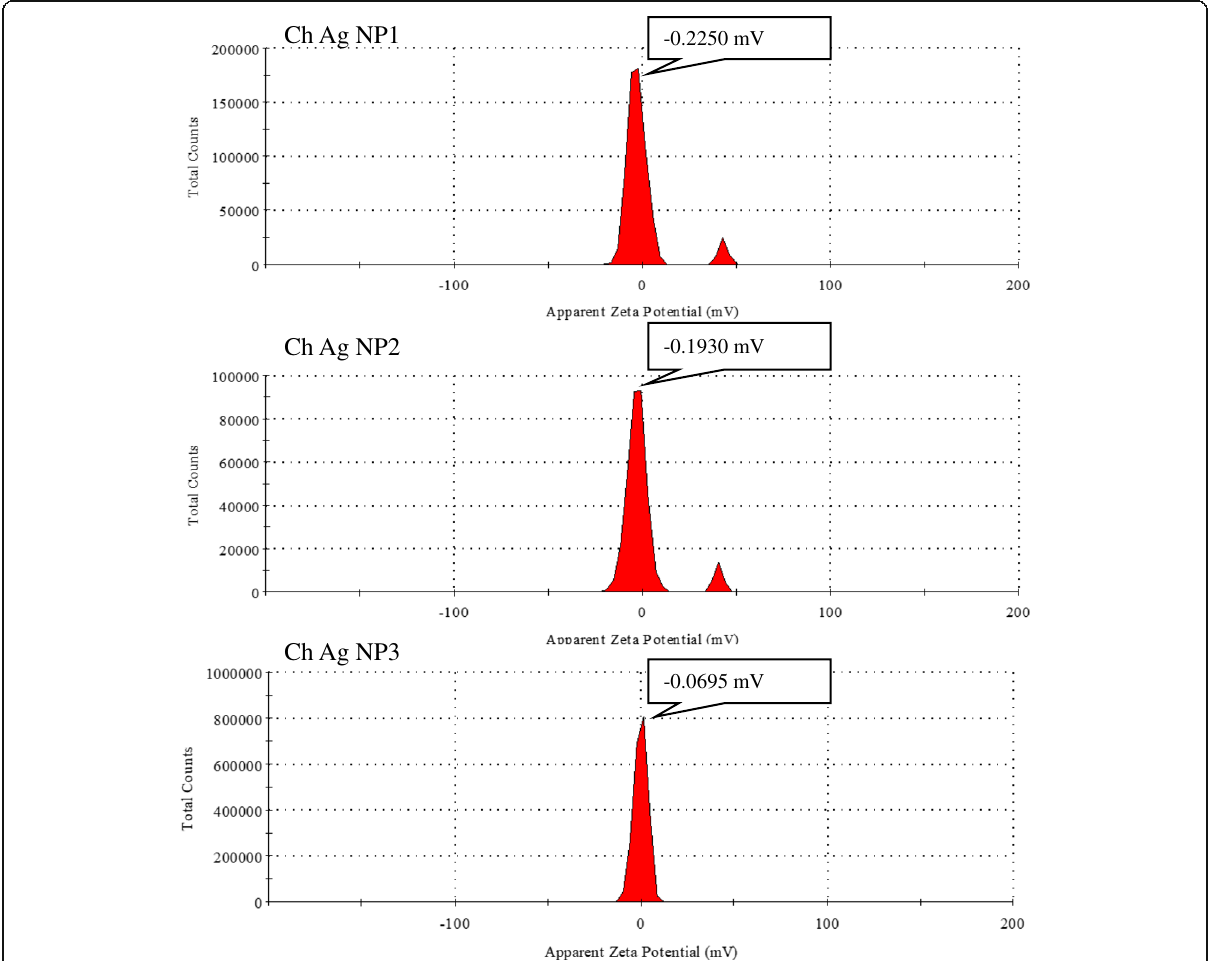
Fig. 2 Zeta potential distribution of Ch-AgNPs. Ch chitosan, NP nanoparticle, Ch-AgNP1 (0.1% Ag), Ch-AgNP2 (0.2% Ag), and Ch-AgNP3 (0.3%